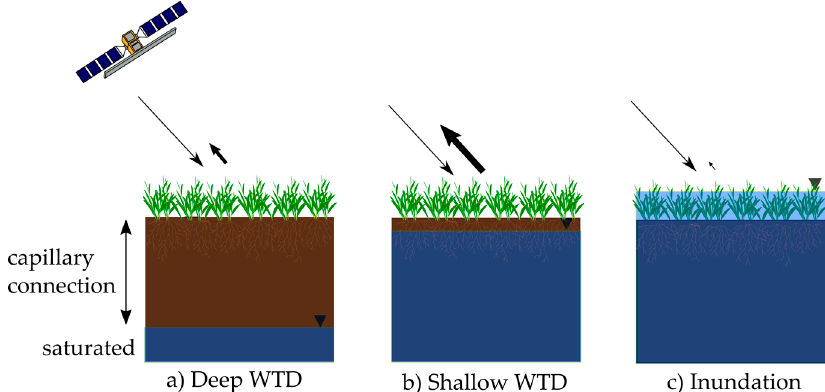
Figure 1. Schematic illustration of backscatter in peatlands with different water table depth (WTD). WTD influences surface soil moisture in the upper centimetres of the soil due to capillary connection. Shown are situations with ( a ) deep WTD and low backscatter, ( b ) shallow WTD with high backscatter and ( c ) inundation with very low backscatter.